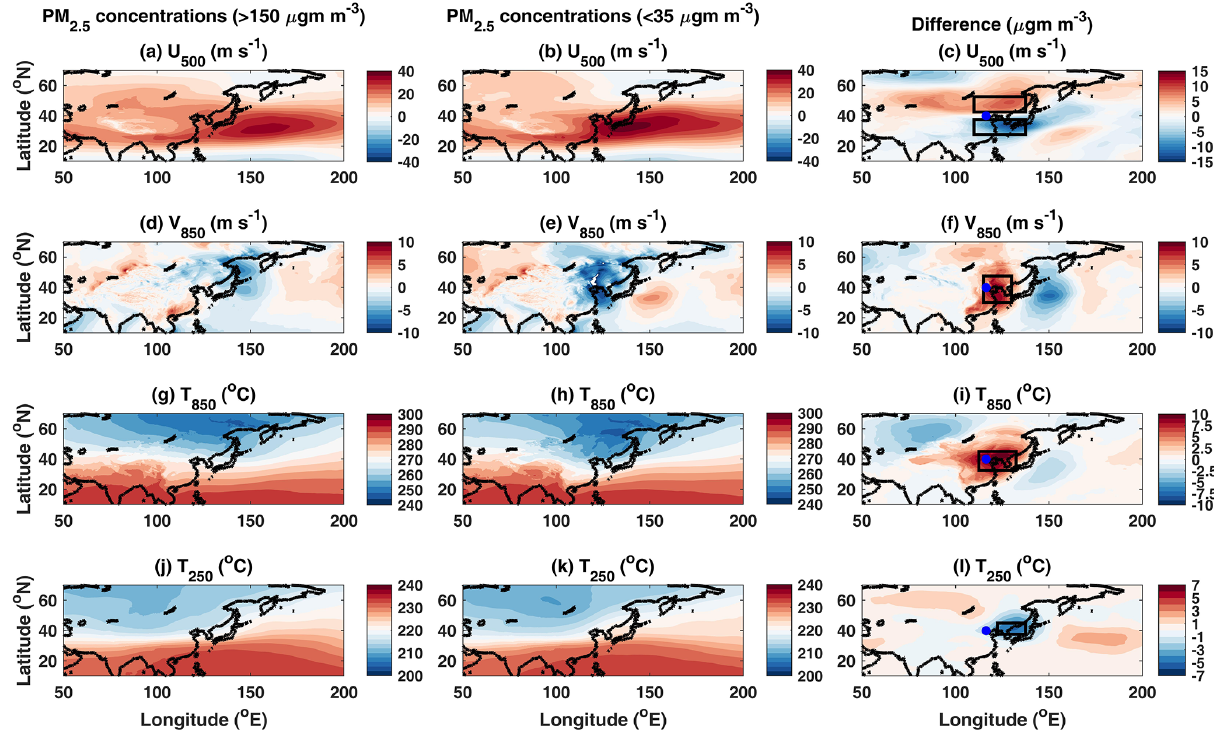
Figure 2. Winter composites of u -wind at the 500hPa level ( U 500 ) over China for all available days for which data were available from the US Embassy station for Beijing in DJF 2009–2017 for (a) high PM 2 . 5 ( > 150µgm − 3 ), (b) low PM 2 . 5 ( < 35µgm − 3 ) concentrations, and (c) the difference between the composites in (a) and (b) . Panels (d–f) show the same as in (a–c) but for v -wind at the 850hPa level ( V 850 ); panels (g–i) show the same as in (a–c) but for temperature at the 850hPa level ( T 850 ), and panels (j–l) show the same as in (a–c) but for temperature at the 250hPa pressure level ( T 250 ). Black rectangles (B1–B5) in the last column show the regions for which spatial means were used for the calculation of the HWI. The blue dots in these panels show the location of